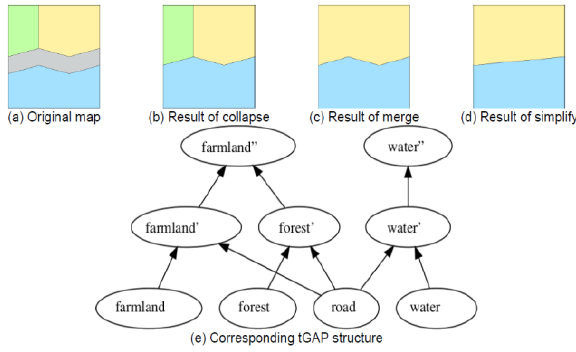
Figure 2: Vario-scale approach, topology connect hierarchical between LoD and good in storing attribute (Meijers, 2011).